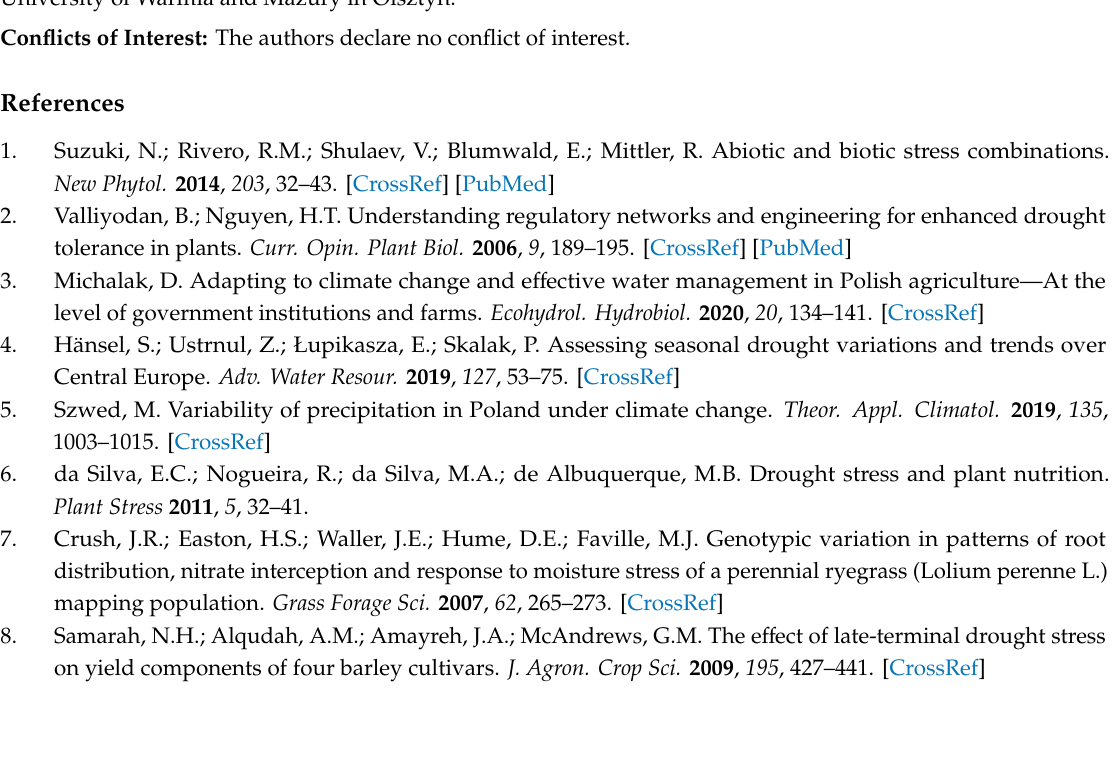
Table S1: Phosphorus content of the above-ground biomass of barley (g kg − 1 dry matter), Table S2: Phosphorus content of the above-ground biomass of rye-grass (g kg − 1 dry